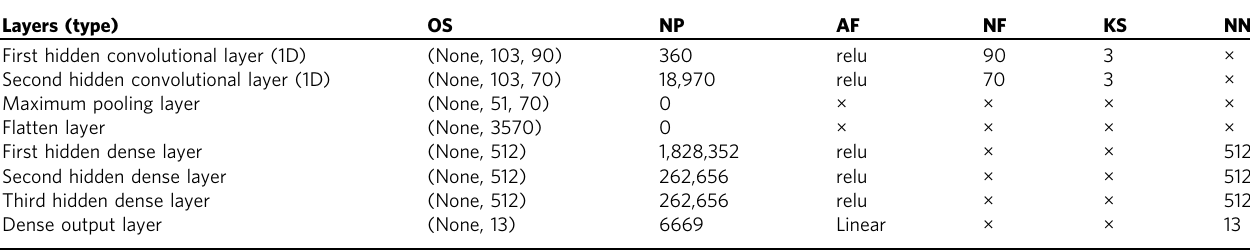
Table 2 Summary of the optimized neural network architecture with layers, output shape (OS), number of parameters (NP), activation function (AF), number of fi lters (NF), kernel size (KS), and number of neurons (NN). Layers